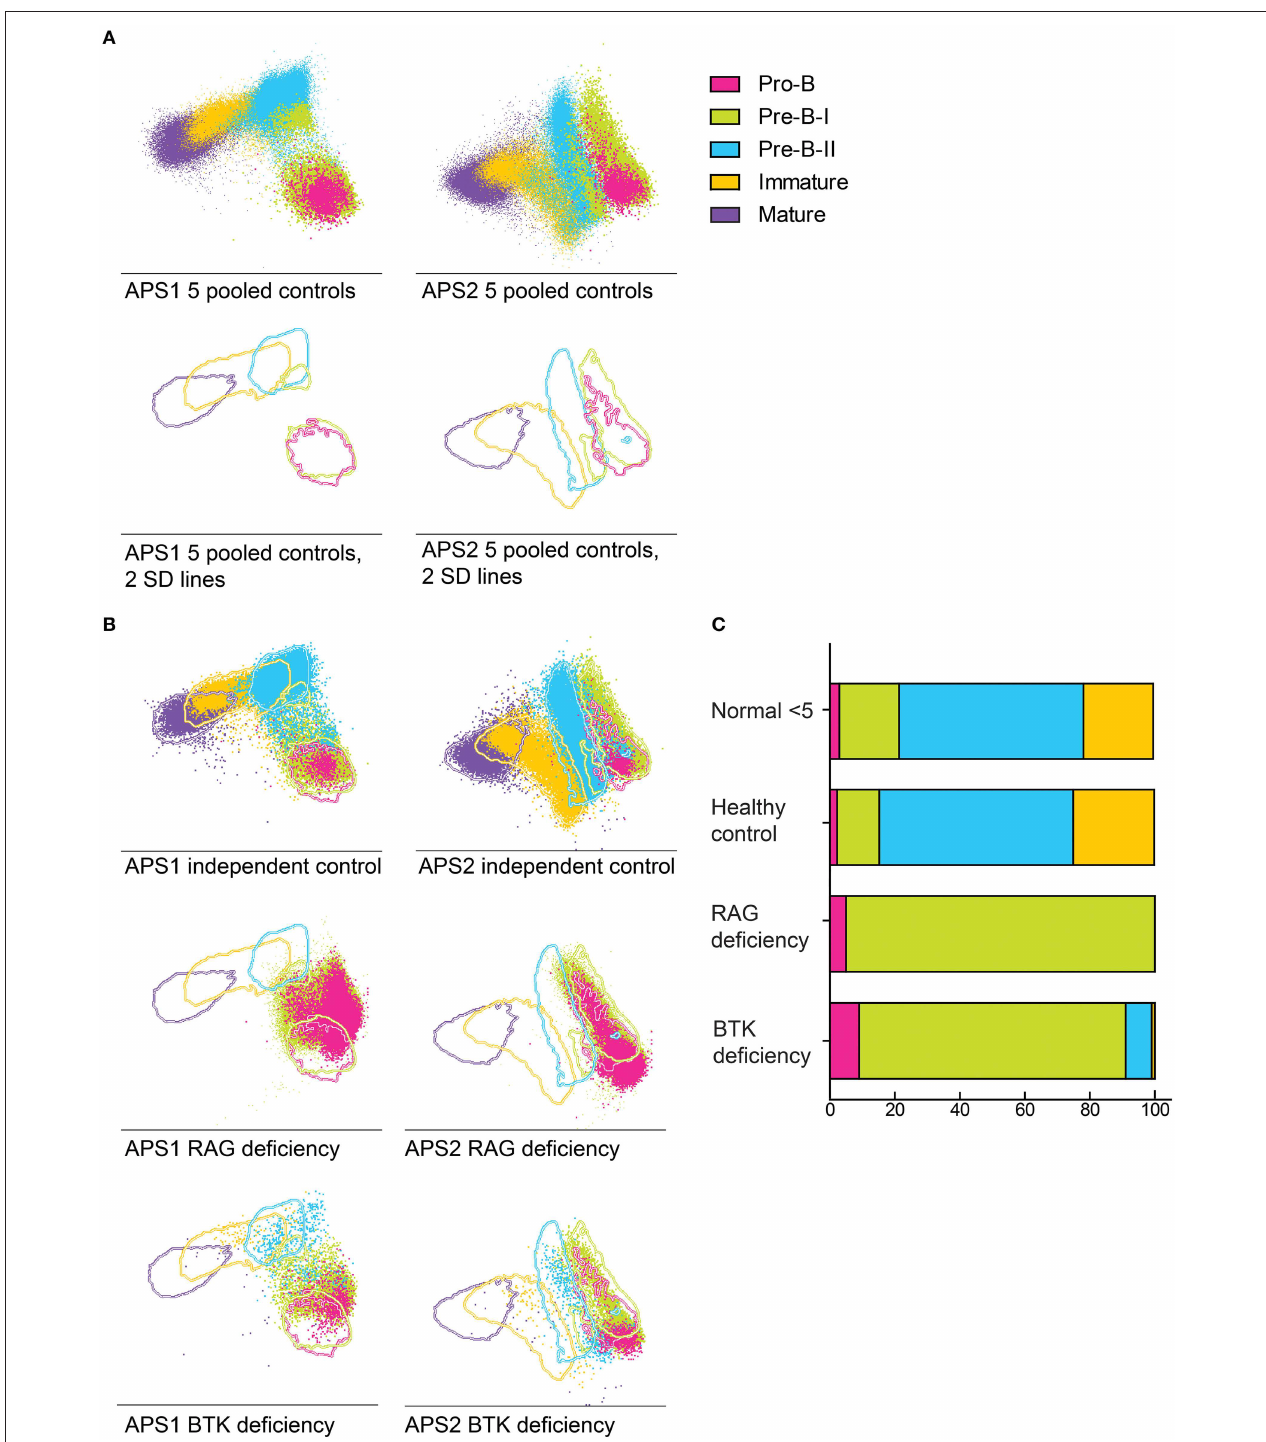
FIGURE 4 | Supervised APS view of BCP populations in healthy bone marrow ( n = 5) indicated by lines at 2SD intervals. (A) BCP populations in a pool of 5 healthy bone marrow samples that were used to create the APS view. Lines indicate the 2 SD range of each population, dot indicate individual cells. The different populations are indicated by the different colors. (B) 2 SD lines of BCP populations derived from a pool of 5 healthy donors, dots indicate total BCP from a sixth healthy donor, a RAG deficient patient and a BTK deficient patient, plotted against the reference pool. (C) Bars indicate the BCP subset distribution of each sample, compared to age matched controls ( < 5